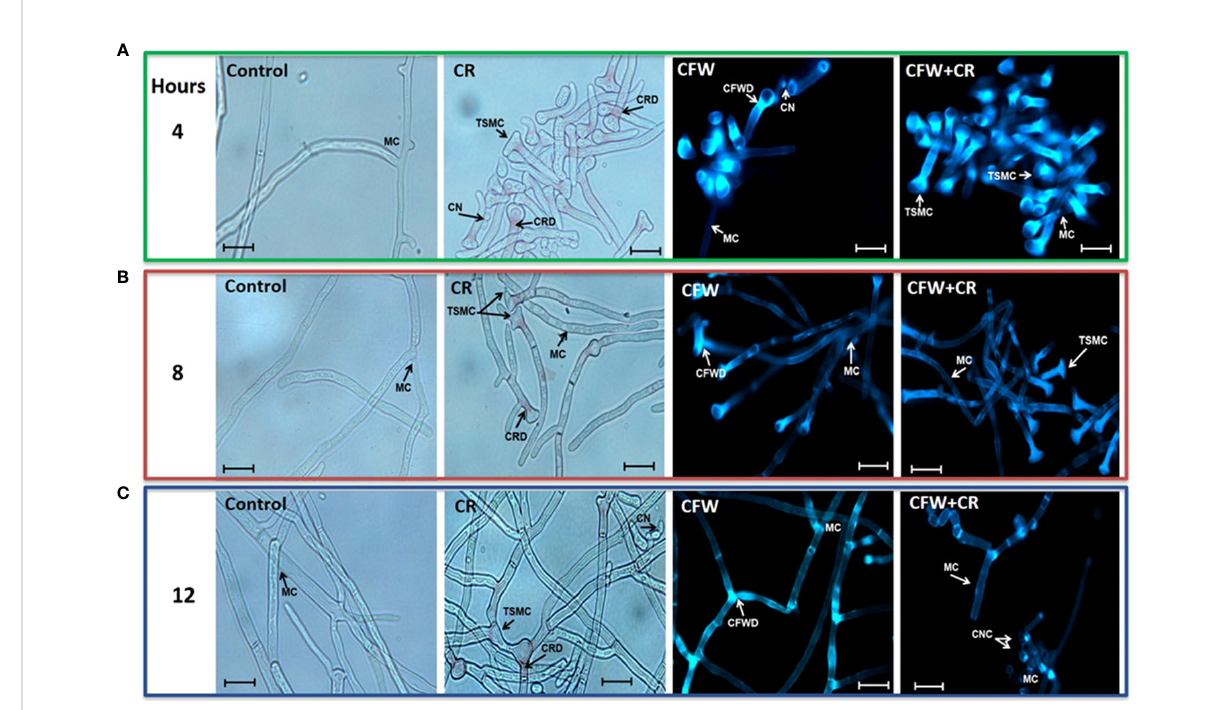
FIGURE 6 Mycelial morphology of S. globosa in response to CR and CFW. The mycelial morphotype was propagated in the absence or presence of CR, CFW or the mixture and after the indicated times, cultures were inspected by bright fi eld and epi fl uorescence microscopies to register the cell morphology. CN, conidia; MC, mycelial cell; TSMC, T-shaped mycelial cell; CRD, CR deposit; CFWD, CFW deposit; CNC, CN clusters. Bar, 20 m m. Reproduced from Ortiz-Ramirez et al., 2021, with permission from Springer Nature, License Number 5315470121400 (May 24,